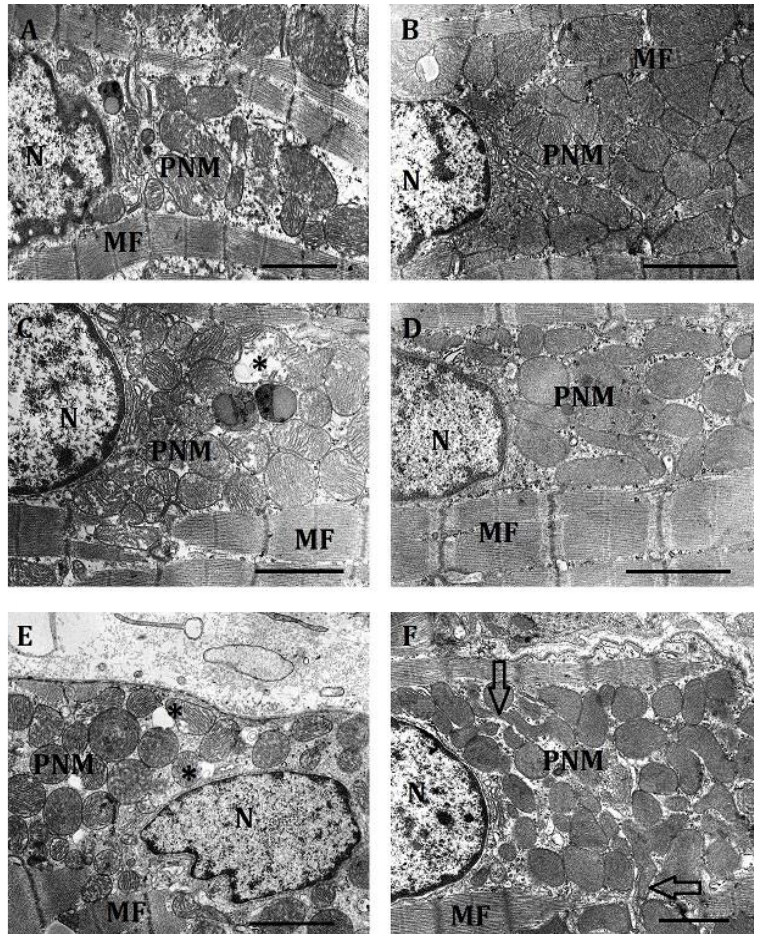
Figure 8. The ultrastructure of a subsarcolemmal region of a cardiomyocyte in rats with low ( A , C , E ) and high ( B , D , F ) resistance to oxygen deficit in mild (FiO 2 = 14%, ( A , B )), moderate (FiO 2 = 10%, ( C , D )) and severe (FiO 2 = 8%, ( E , F )) hypoxia. Tissue samples were taken 30 min after the start of the respective hypoxic training. SSM, subsarcolemmal mitochondria; MF, myofibrils. Arrow—nanotunnels; asterics—lysed mitochondria. Scale bar, 0.5 μm.